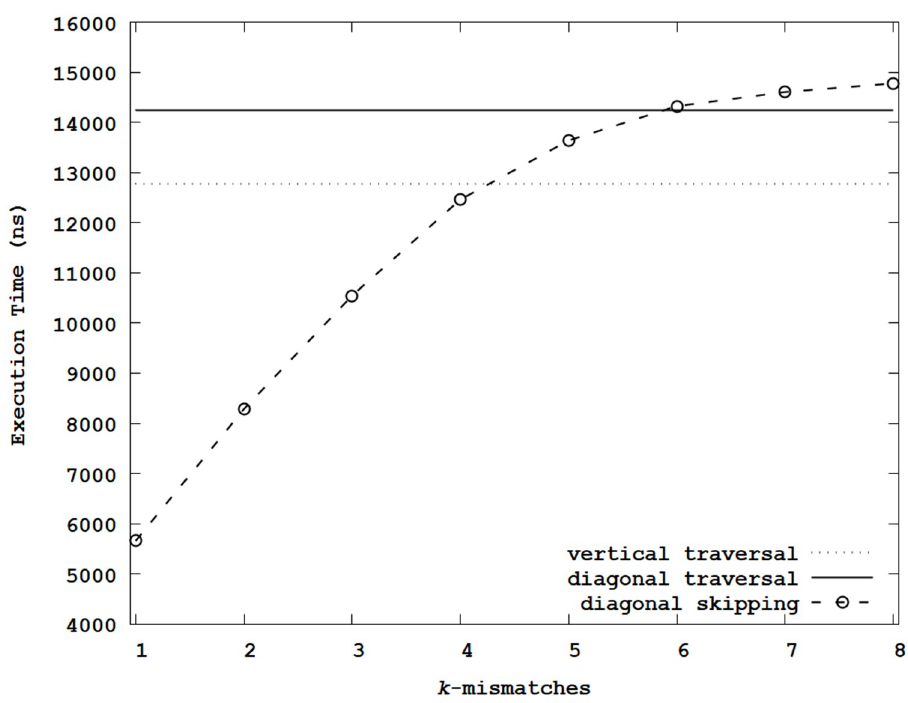
Fig 7. Average execution times of the generalized edit distance metric using similarity in